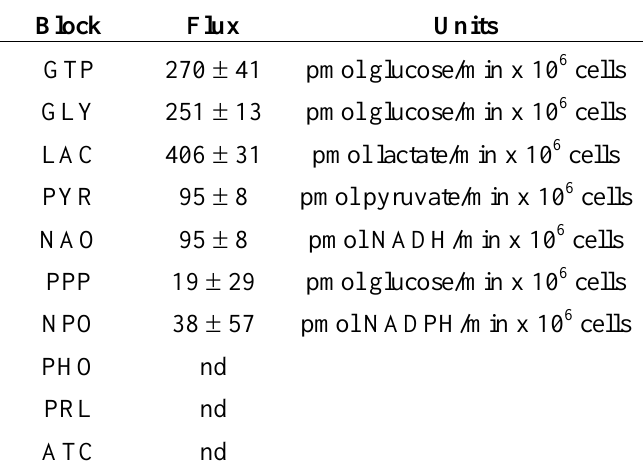
Table 1. Reaction block fluxes in healthy